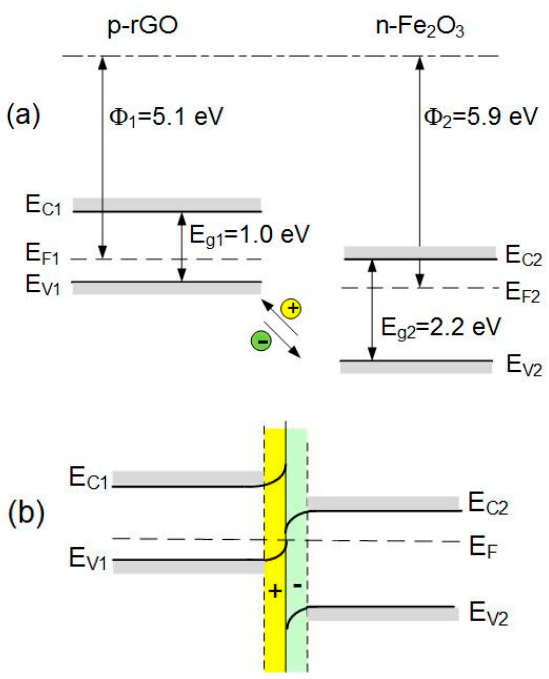
Figure 10. Diagram of energy bands of p-rGO and n-Fe 2 O 3 before ( a ) and after ( b ) contact with the formation of a p-n heterojunction.